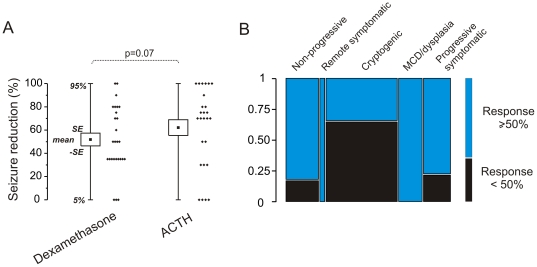
Efficacy of dexamethasone and ACTH in drug resistant pediatric epilepsy.Data relative to the efficacy of methyl-prednisolone and hydrocortisone are presented in Figure S3. (A) A total of 53 treatments were evaluated. Treatments were administered as described in the Methods and Table S1. Seizures were assessed by behavioral and EEG observations. The values reported refer to decrease in seizure burden compared to baseline EEG seizure quantification. T-test was used to assess significance. (B) Mosaic plot showing the correlation between etiology of epilepsy and likelihood of a response ≥50%. Note that etiology did not always predict response. Noteworthy, dysplasia and other non-encephalopathic diseases responded to the treatments. Cryptogenic seizures were least affected. Bar width is proportional to the number of observations. Colors refer to the response as indicated in the inset.